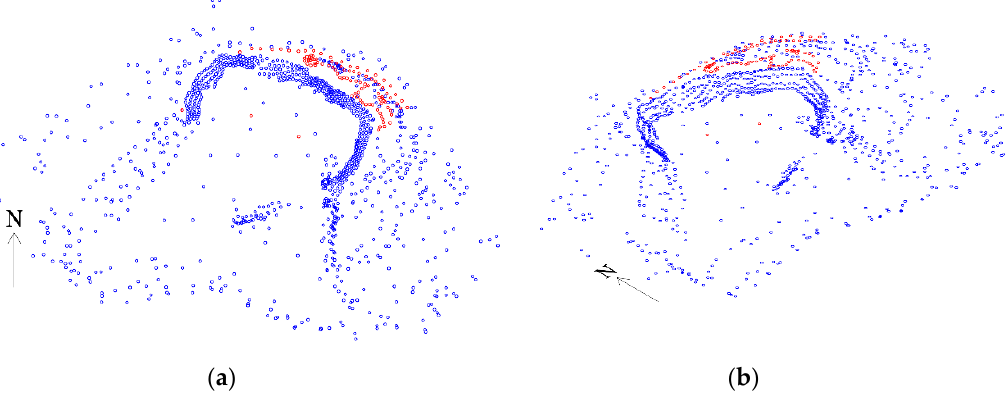
Figure 7. Two views of terrain points of the open-pit mine from the second survey period: by TS— blue circle, by GNSS receiver—red circle. ( a ) View from above; ( b ) Isometric view.